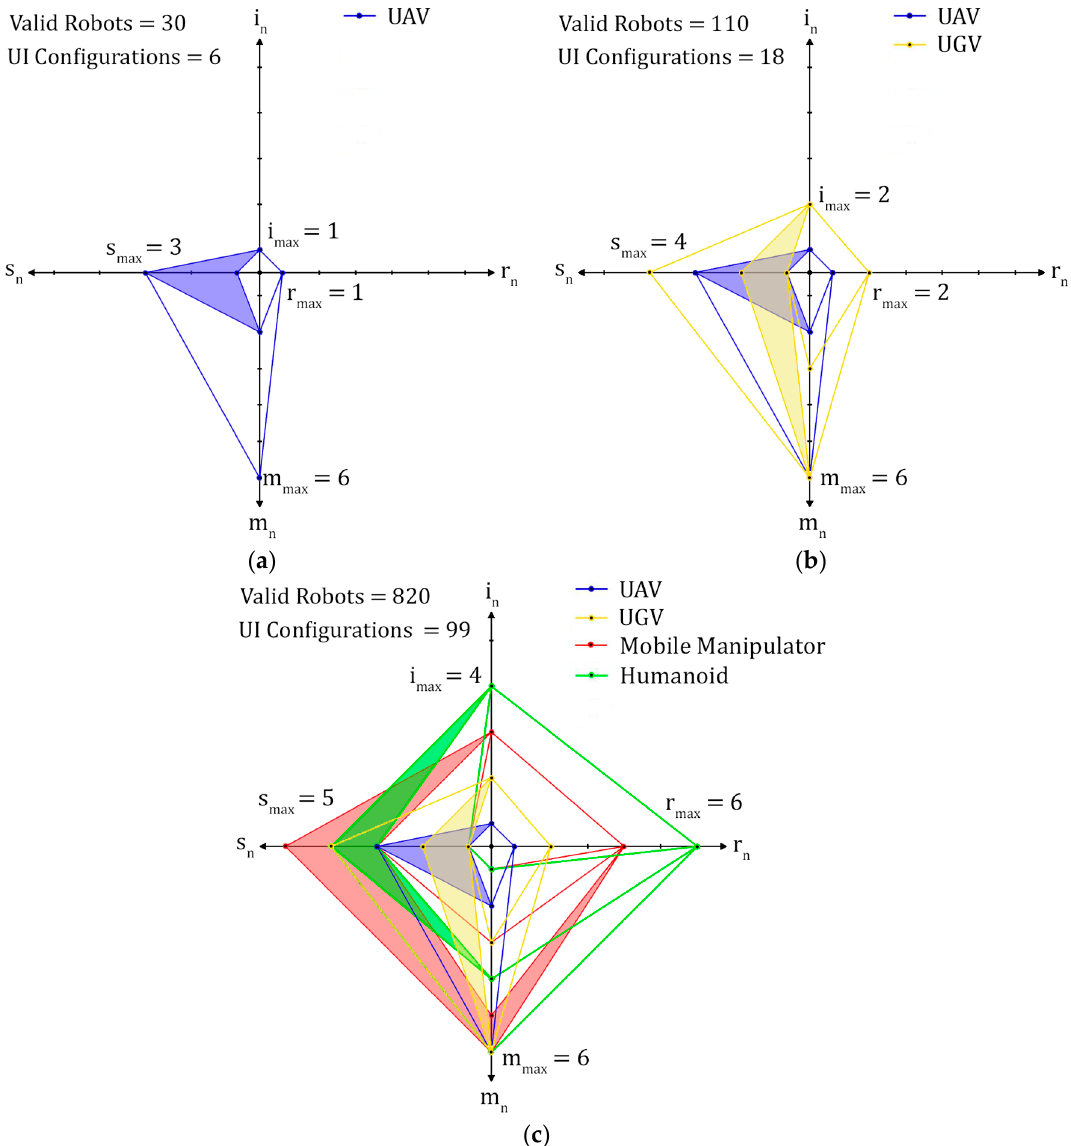
Figure 9. Radar plots for toolbox results for ( a ) Case 1, ( b ) Case 2, and ( c ) Case 3. Shaded areas represent characteristic selections which are numerically continuous.